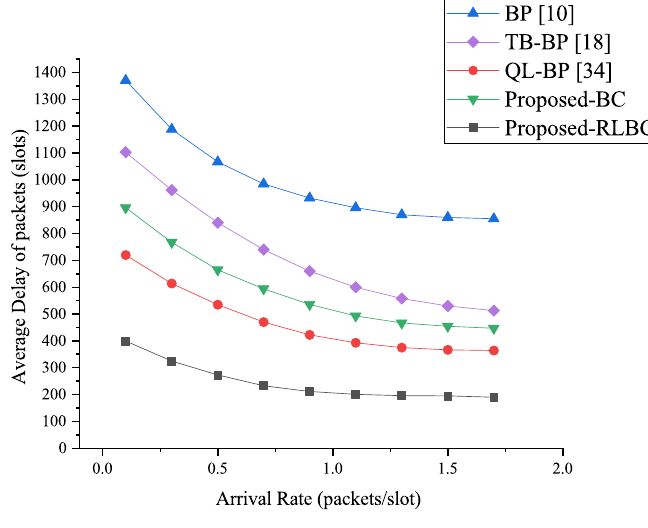
Figure 6. Average delay of packets with 25% malicious